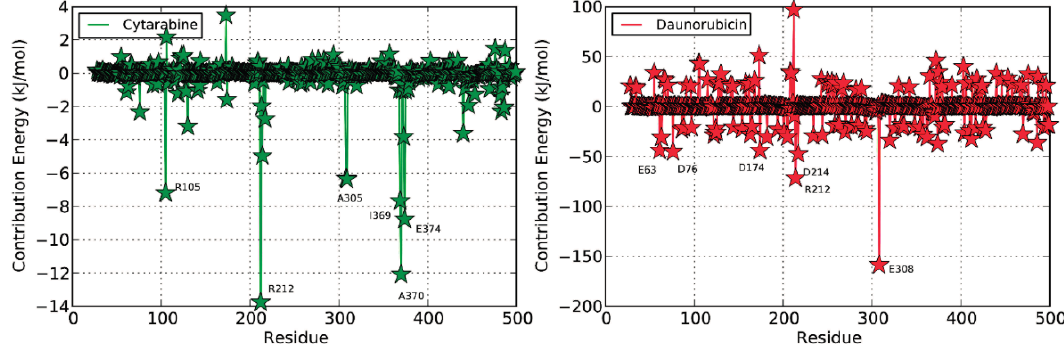
Figure 5. Metabolic site prediction using SMARTCyp for the anticancer drugs. ( A ) The cytarabine structure contains a cytosine base with an arabinose sugar moiety. The primary site of metabolism (SOM) in cytarabine is the amino group in the cytosine base. The secondary predicted SOM is the acetyl carbon (C16), and the tertiary SOM is the 11th carbon in the arabinose sugar moiety; ( B ) Daunorubicin features a tetracyclic ring structure and daunosamine moiety. The primary SOM is a carbon (C4) in the amino sugar. The secondary and tertiary SOMs are carbon (C6) and an amino group of the daunosamine moiety, respectively; ( C ) Doxorubicin has a tetracyclic ring structure and daunosamine moiety. The predicted results of SMARTCyp were similar as those for doxorubicin; ( D ) SMARTCyp predicted the primary SOM as carbon (C54) near the pyrimidine ring out of the two multi-ringed units, vindoline and catharanthine. The secondary SOM is carbon (C57) in the pyrimidine ring of the vindoline ring, and the tertiary SOM is the carbon (C18) in the catharanthine ring of